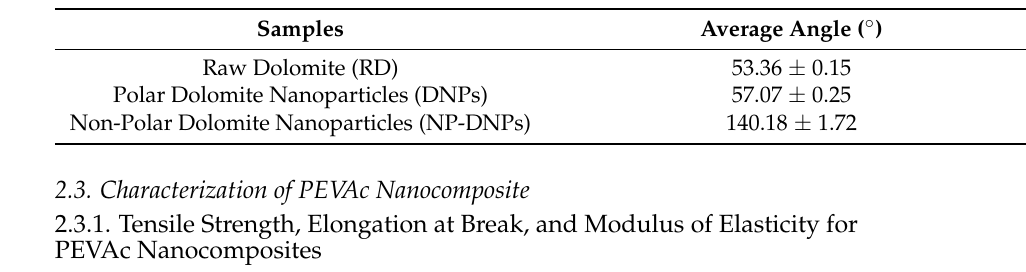
Figure 10. Images of a water droplet on the surface of ( a ) raw dolomite (RD), ( b ) dolomite nanoparticles (DNPs), and ( c ) non-polar dolomite nanoparticles (NP-DNPs). Table 2. The average contact angle of raw dolomite (RD), dolomite nanoparticles (DNPs), and non-polar dolomite nanoparticles (NP-DNPs).